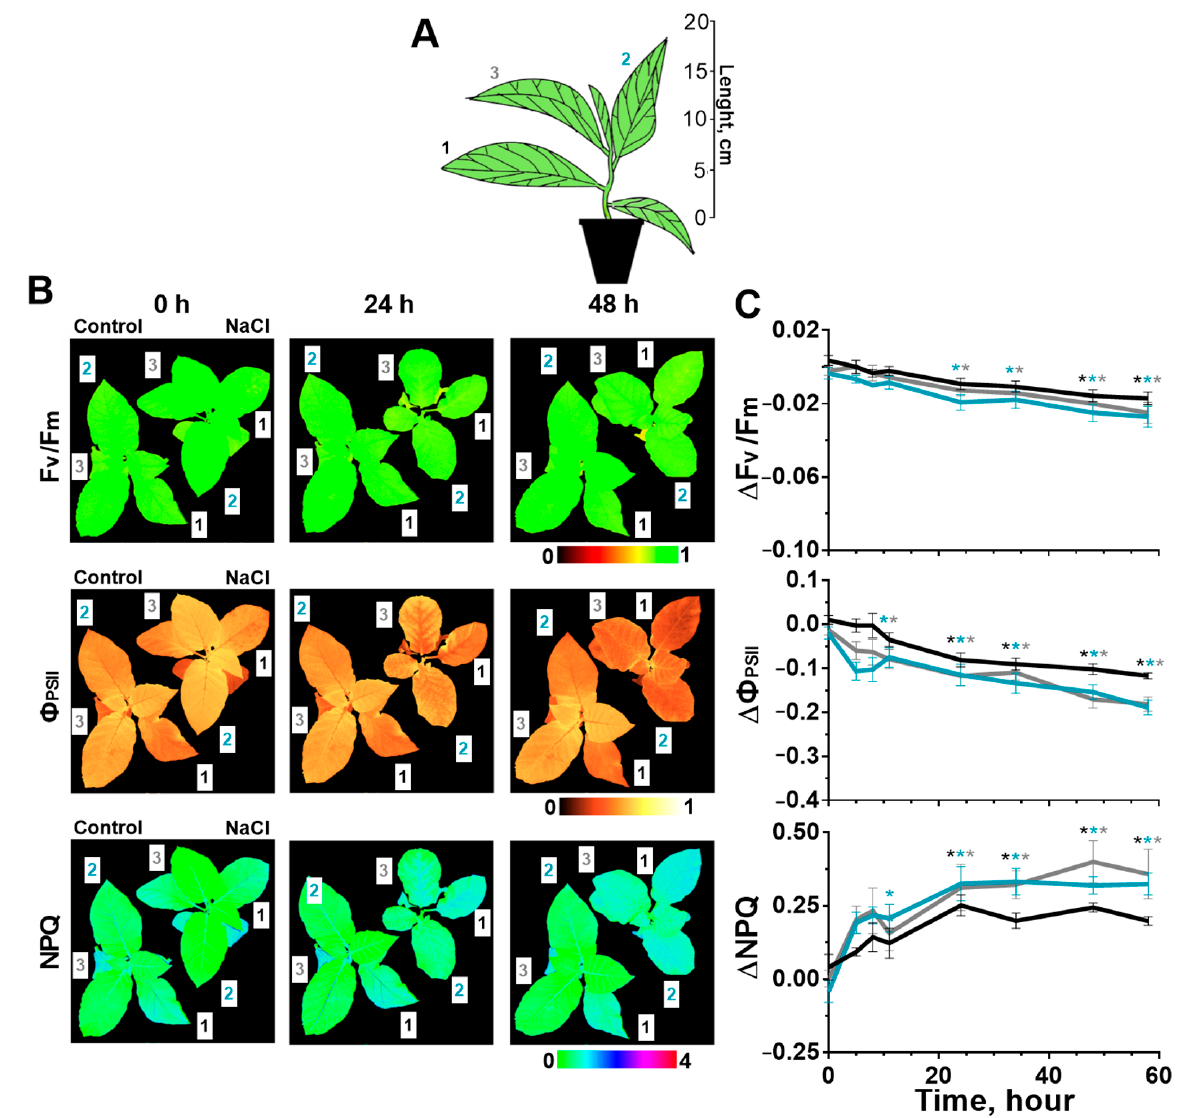
Figure 1. Effect of salt stress on photosynthesis in three tobacco leaves located at different height on shoot (1, 2, 3) ( A ). Changes of F v /F m , φ PSII and NPQ are demonstrated as whole-plant imaging in the pseudo-color scale in control (Control) and salt–treated (NaCl) plants at three time points (0, 24 and 48 h) ( B ), as well as presented in the form of changes relative to control values (1—black, 2—blue, 3—gray) ( C ). The data are presented as mean ± SEM (n = 9), * p < 0.05 control versus salt treatment.